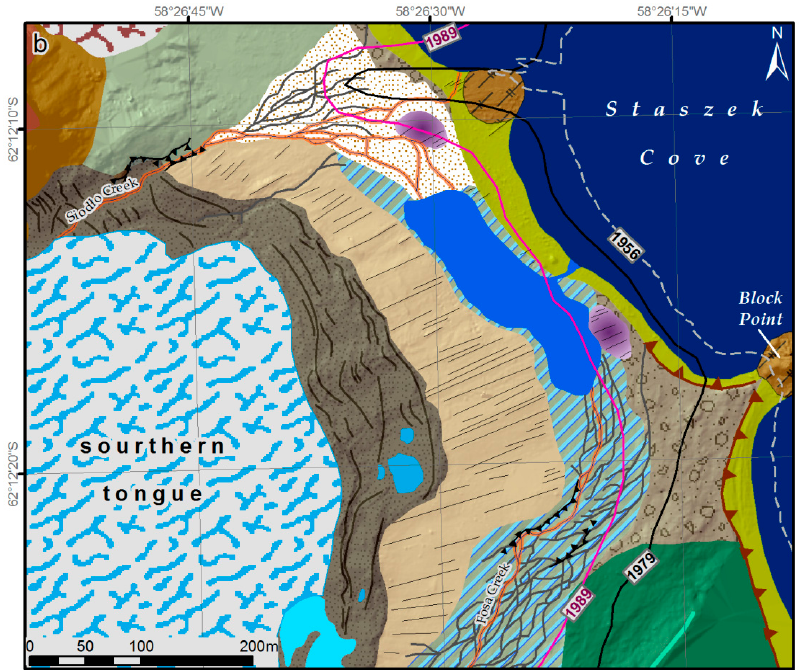
Figure 9. Geomorphological map of the study area: ( a ) northern forefield and ( b ) southern forefield. Reference system: WGS 1984, UTM zone 21S, and geoid EGM96.